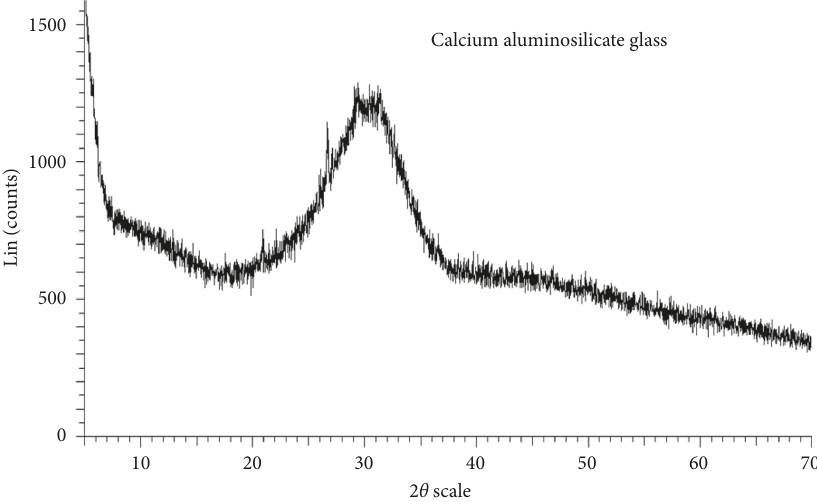
Figure 4: X-ray diffraction pattern of a SGGBF slag with a characteristic amorphous